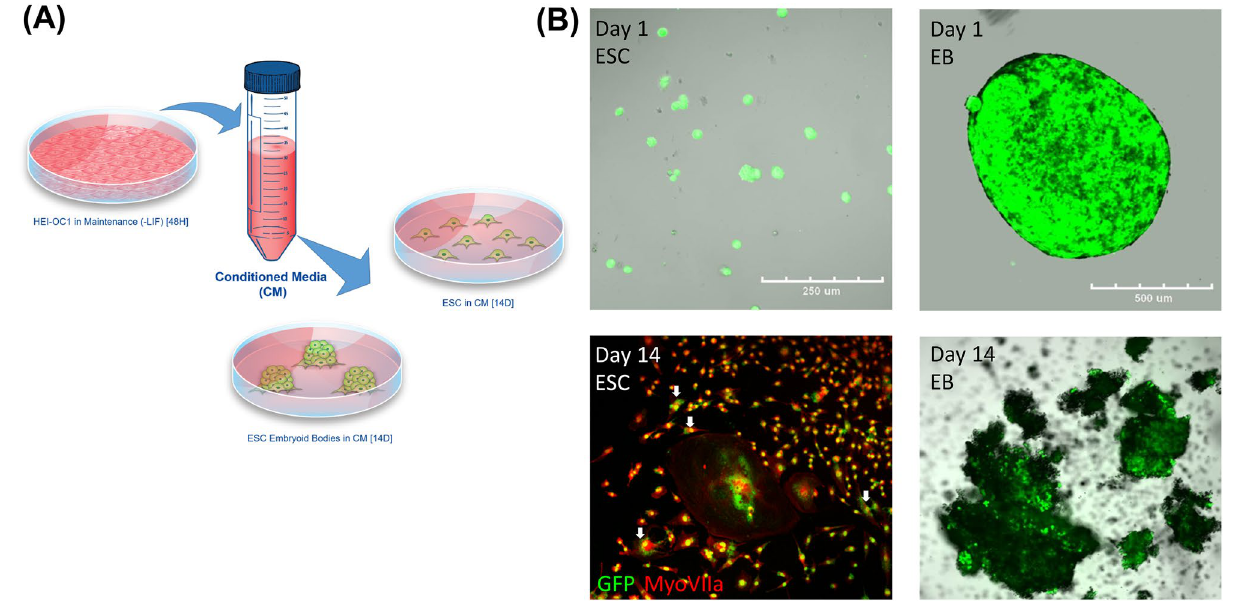
Figure 5. Non-contact co-culture of dissociated ESCs with HEI-OC1 cells induced differentiation into otic cells. ( A ) Methodology of non-contact co-culture is shown. After inoculating pre-conditioned HEI-OC1 cells in culture media for 48 h, soup of the culture was acquired and added to dissociated ESCs and EBs generated by hanging drop. Both dissociated ESCs and EBs were cultured with CM for 14 days. ( B ) Upper row is a